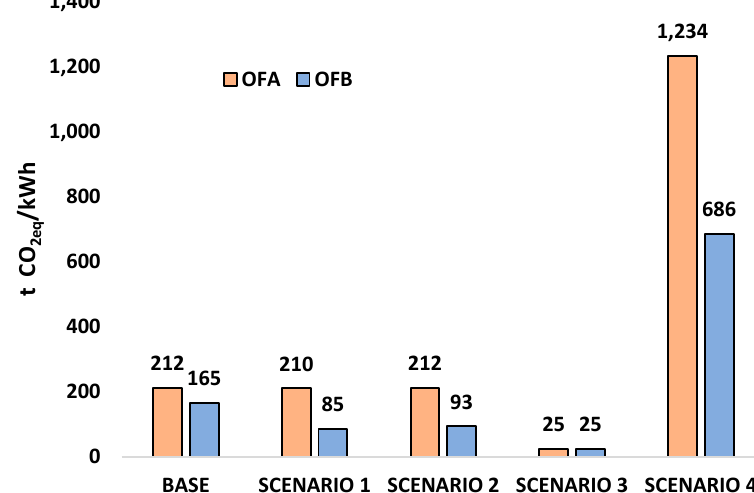
Figure 9. tCO 2eq /kWh for the scenarios considered in OFA and OFB.